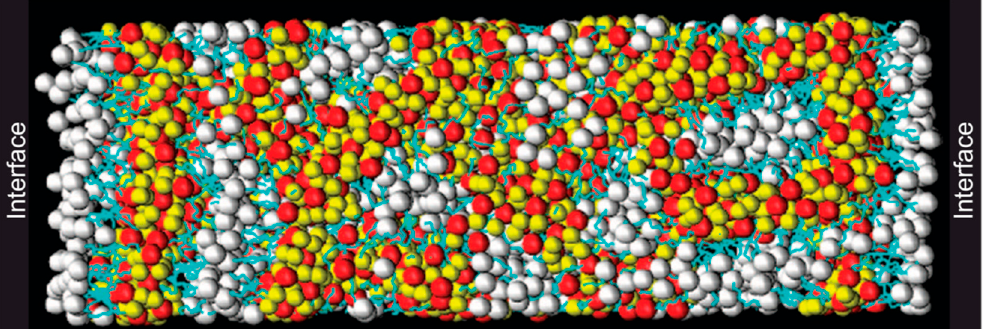
Figure 2. Molecular dynamics simulation of an ionic liquid consisting of imidazolium-based cations and NO 3 − sandwiched between two vacuum interfaces. The white spheres represent the nonpolar cationic tail groups, the gold spheres the charged cationic head groups, the red spheres the anions, and the blue lines the cathodic side chains connecting the head and tail groups. Adapted from Wang et al. [28].